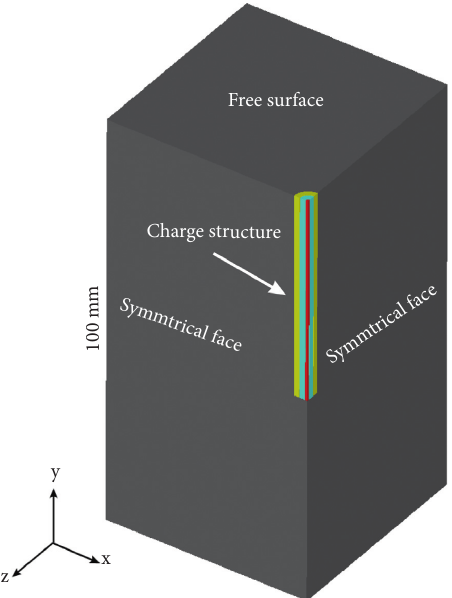
Figure 21: 3D numerical